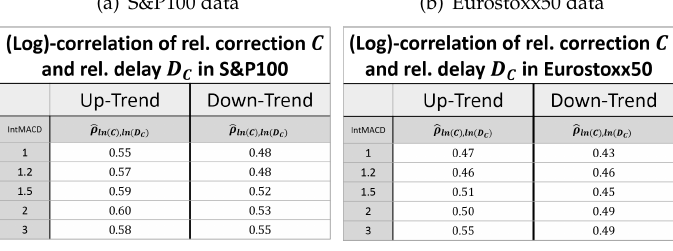
Table 11. Correlation between the logarithms of the relative (rel.) correction C and relative delay D C